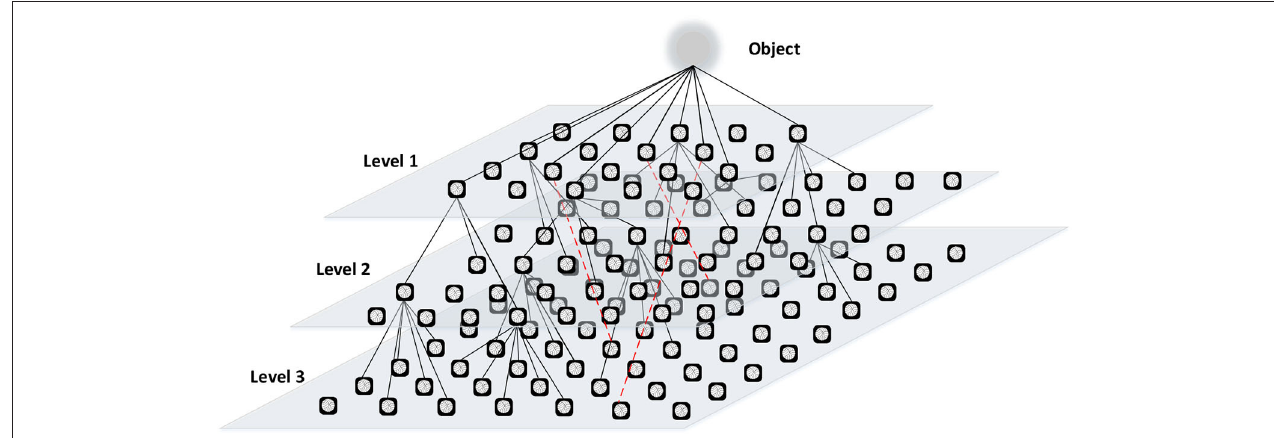
FIGURE 3 | Examples of quantum knowledge graphs.